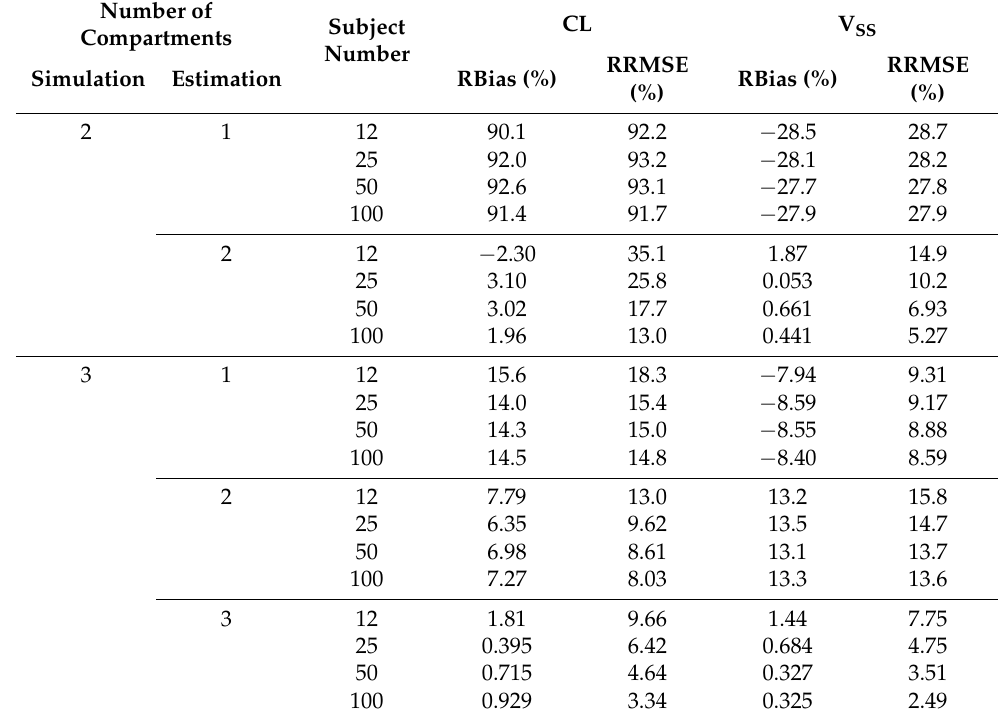
Table 2. Relative bias (RBias) and relative root mean square error (RRMSE) of total clearance and steady-state volume of distribution when the number of compartments for PK model is equal to or less than that for the initially developed model.